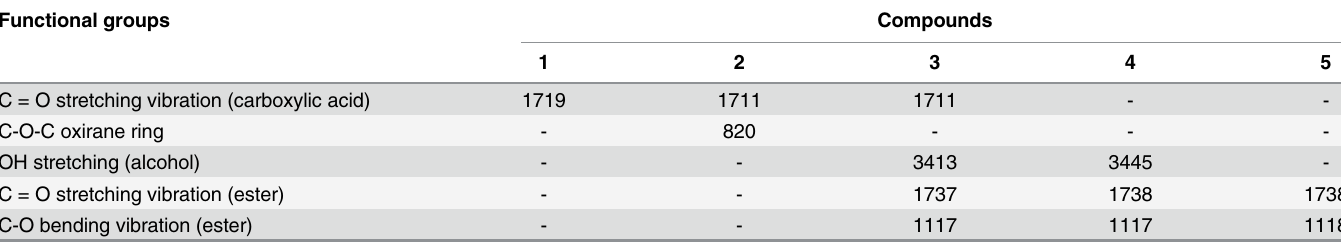
Table 2. The main FTIR functional groups wavenumbers of linoleic acid and synthesis